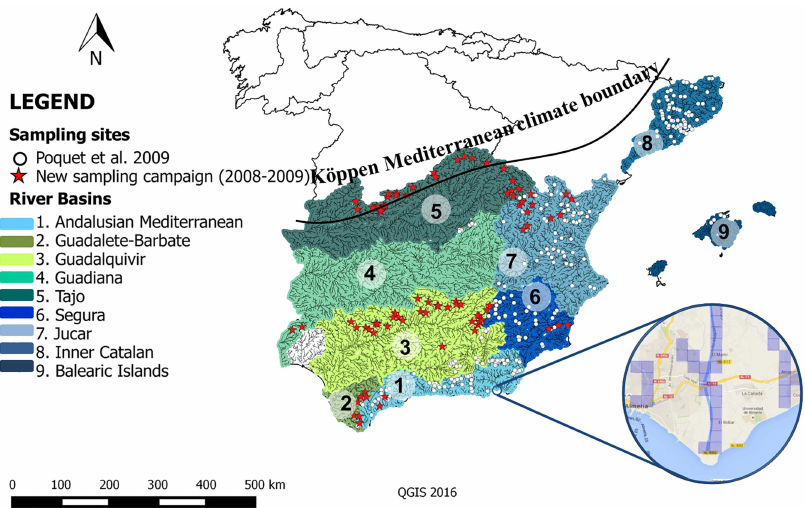
Fig 1. Study area. Black line represents the Ko¨ppen (1923) Mediterranean climate boundary.River basins, grids of 500x500m where model was applied(blue squaresin map and zoom), and samplingsites (circles and stars) are represented.“Circles” indicate those sites includedin Poquet et al. 2009 and “Stars” those added in the new